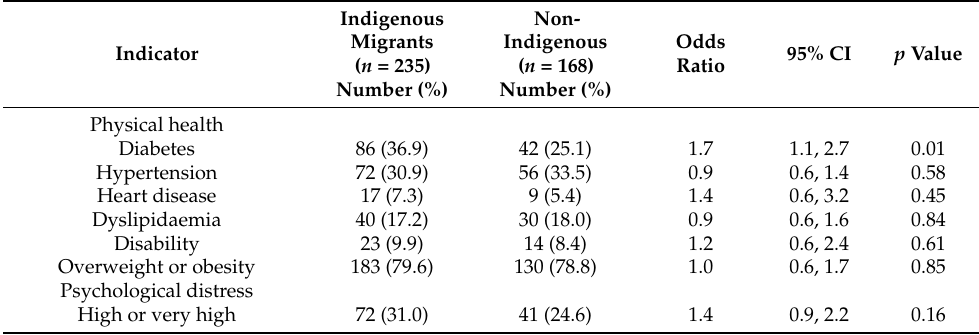
Table 3. Physical health and psychological distress according to indigenous migrant and non- indigenous category.